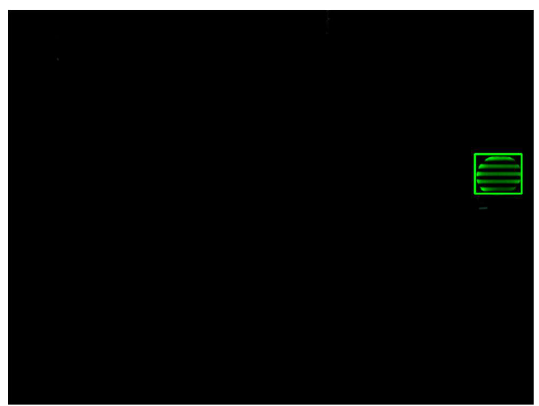
Figure 11. Target signal source LED selection and tracking algorithm initializing without interference.